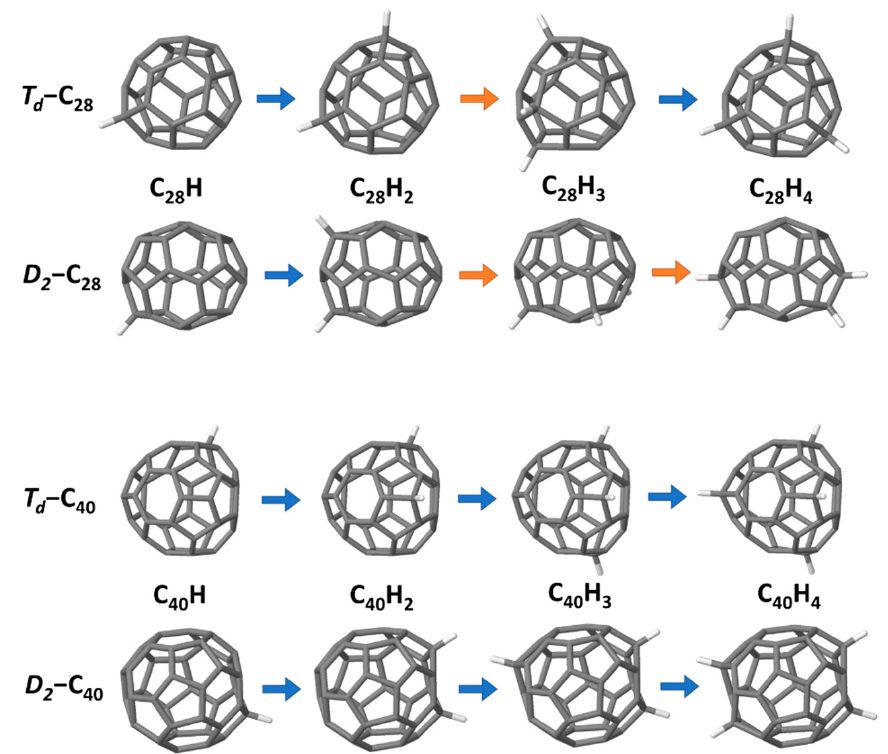
Figure 9. The lowest-energy C n H m structures for n = 28 and 40, and m = 1 . . . 4 for the T d and D 2 isomers calculated using GFN2-xTB, testing all symmetry-inequivalent possibilities. Grey and white in molecular structures represent carbon and hydrogen atoms, respectively. Blue arrow indicates hydrogenation in a sequential route, while orange arrow indicates nonsequential hydrogenation.